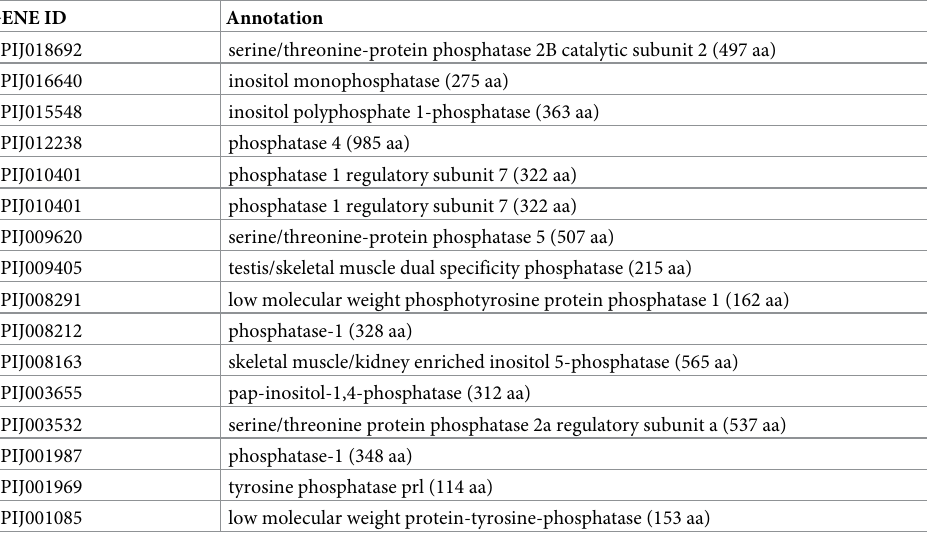
Table 2. Phosphatases and associated regulatory subunits detected in the Culex sperm proteome.